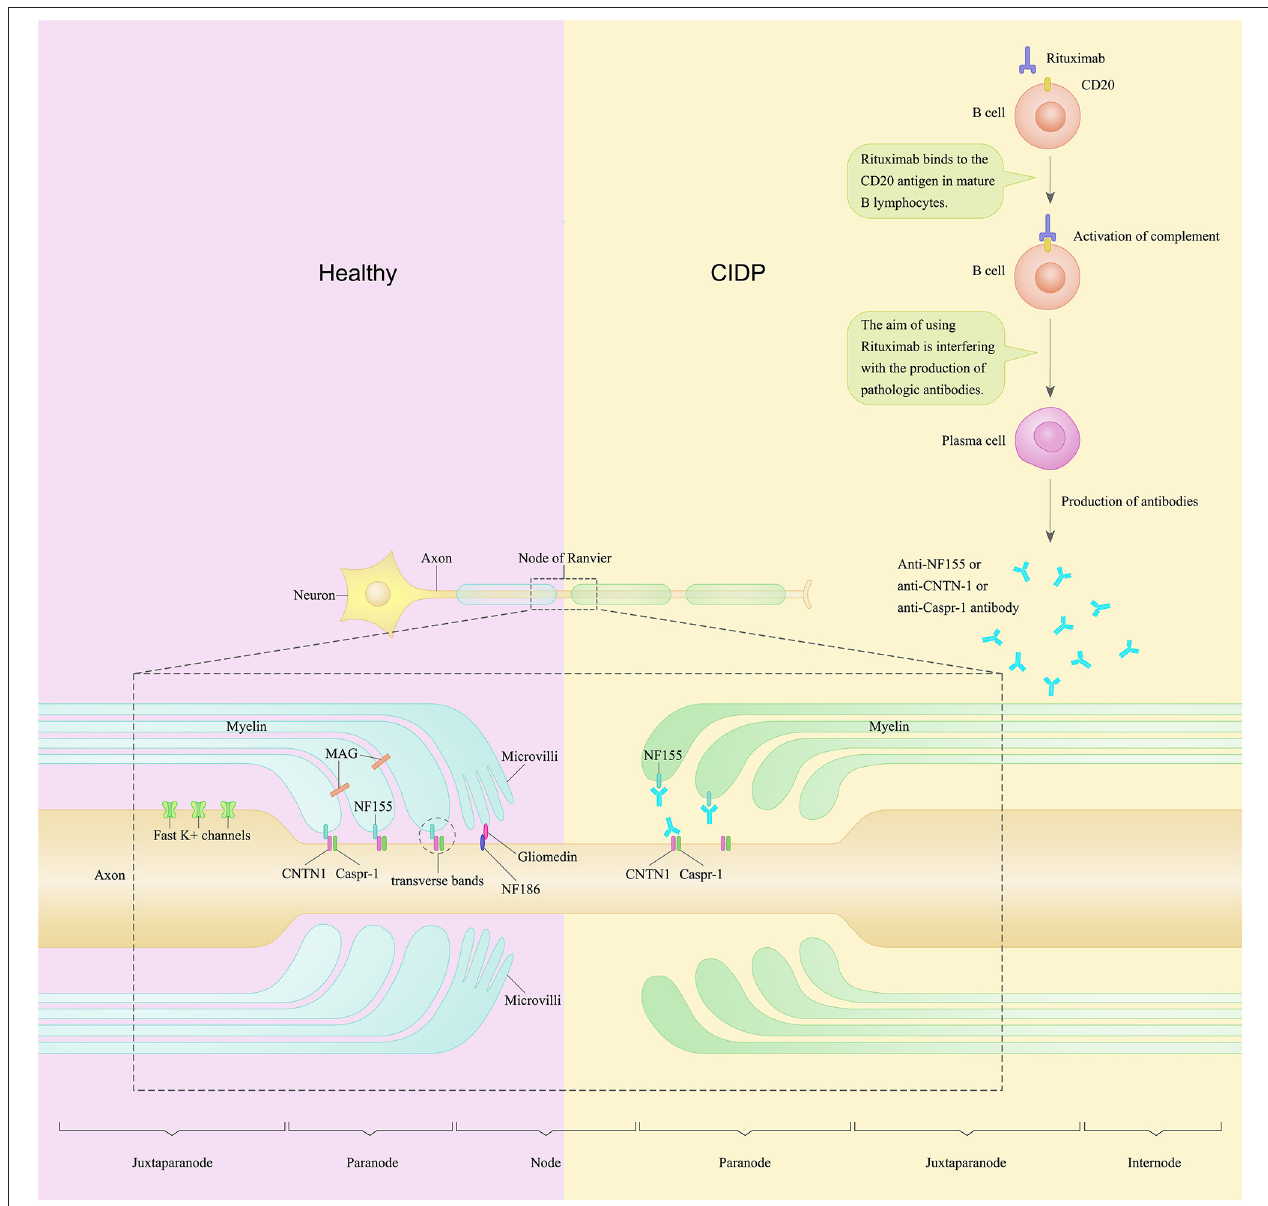
FIGURE 1 | A schematic of the node of Ranvier and paranode in the peripheral nerve of a patient with chronic inflammatory demyelinating polyradiculoneuropathy compared to healthy control. In the peripheral nervous system, Schwann cells contact and wrap around axons and create polarized domains including the node, paranode, juxtaparanode, and internode. Neurofascin-155 (NF155) along with contactin-1 (CNTN1) and contactin-associated protein (CASPR1) form the complex named transverse bands. Transverse bands anchor loops of myelin to the axon at the paranode. In CIDP patients, anti-NF155 autoantibodies may bind to NF155 and disable NF155, thus cause a selective loss of the transverse bands at the paranode loops. Rituximab is a monoclonal antibody against CD20 and has been found to be efficacious in several cases of CIDP. The purpose of using rituximab is to interfere with the production of pathological autoantibodies in CIDP